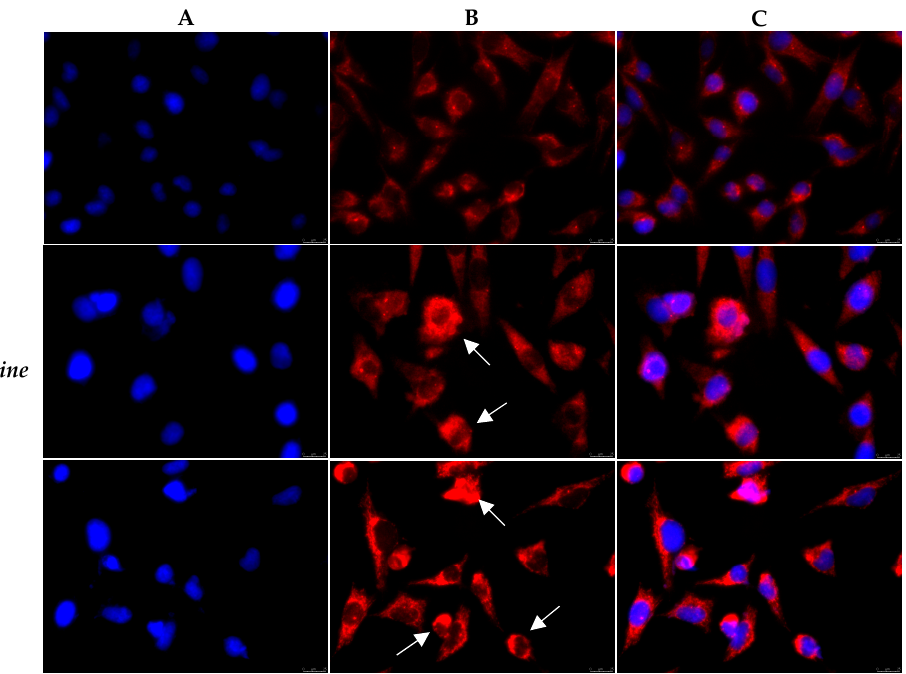
Figure 7. β -tubulin immunofluorescence analysis. A2058 cells were treated with ethanolic A. cherimola Mill. leaf extracts (ACE) at its IC 50 value, with Vinblastine at 1 µ M or with vehicle (DMSO, CTRL). Images were acquired at 40 × magnification. ACE affected the normal tubulin assembly, similarly to Vinblastine. ( A ) DAPI ( λ ex/em = 350/460 nm); ( B ) Alexa Fluor ® 568 ( λ ex/em = 644/665 nm); ( C ) overlay channel. Images are representative fields of three independent experiments.